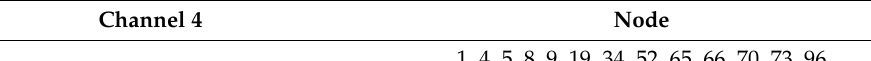
Figure 11. Channel 4 Grouping. Table 9 is a node that enters the channel group 4. Table 9. Node channel 4 .